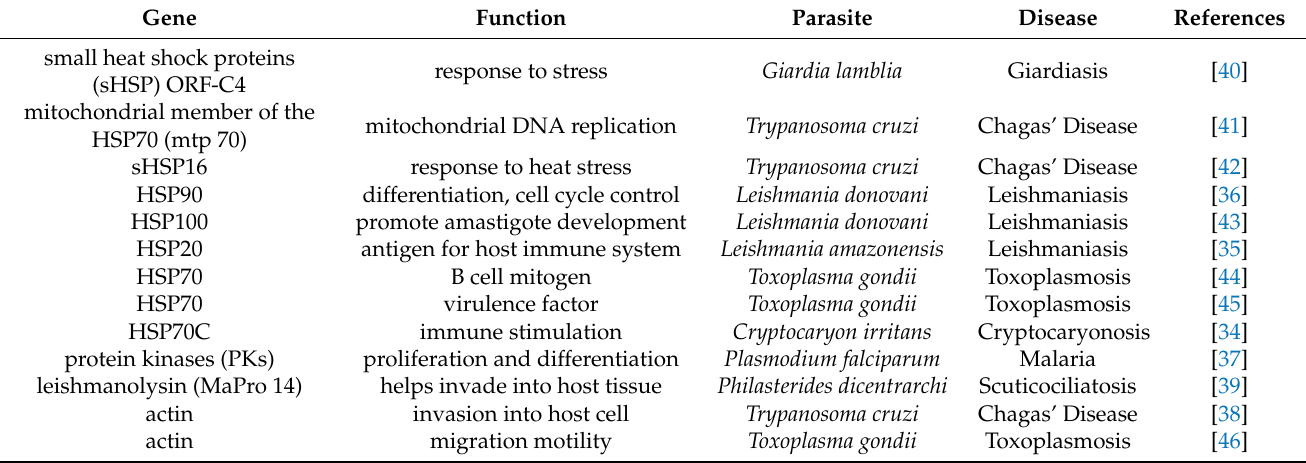
Table 3. Parasitism related genes characterized in protozoan